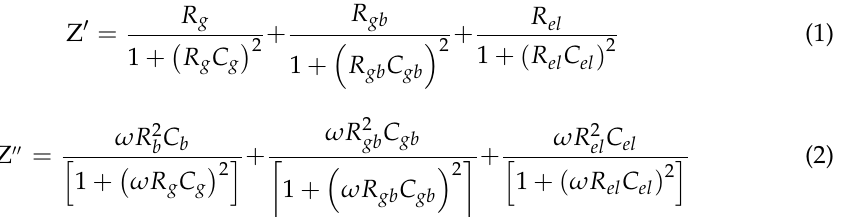
Figure 3. XPS spectra of Ca 2 Fe 2 O 5 for Fe. Table 1. The structural parameters for Ca 2 Fe 2 O 5 obtained from the refinement of powder X-ray dif- fraction. Space group: Pnma , a = 5.4247 (5), b = 14.7756 (1), c = 5.5977 (5), Rp = 0.013, wRp = 0.018, and χ2 = 1.941 .